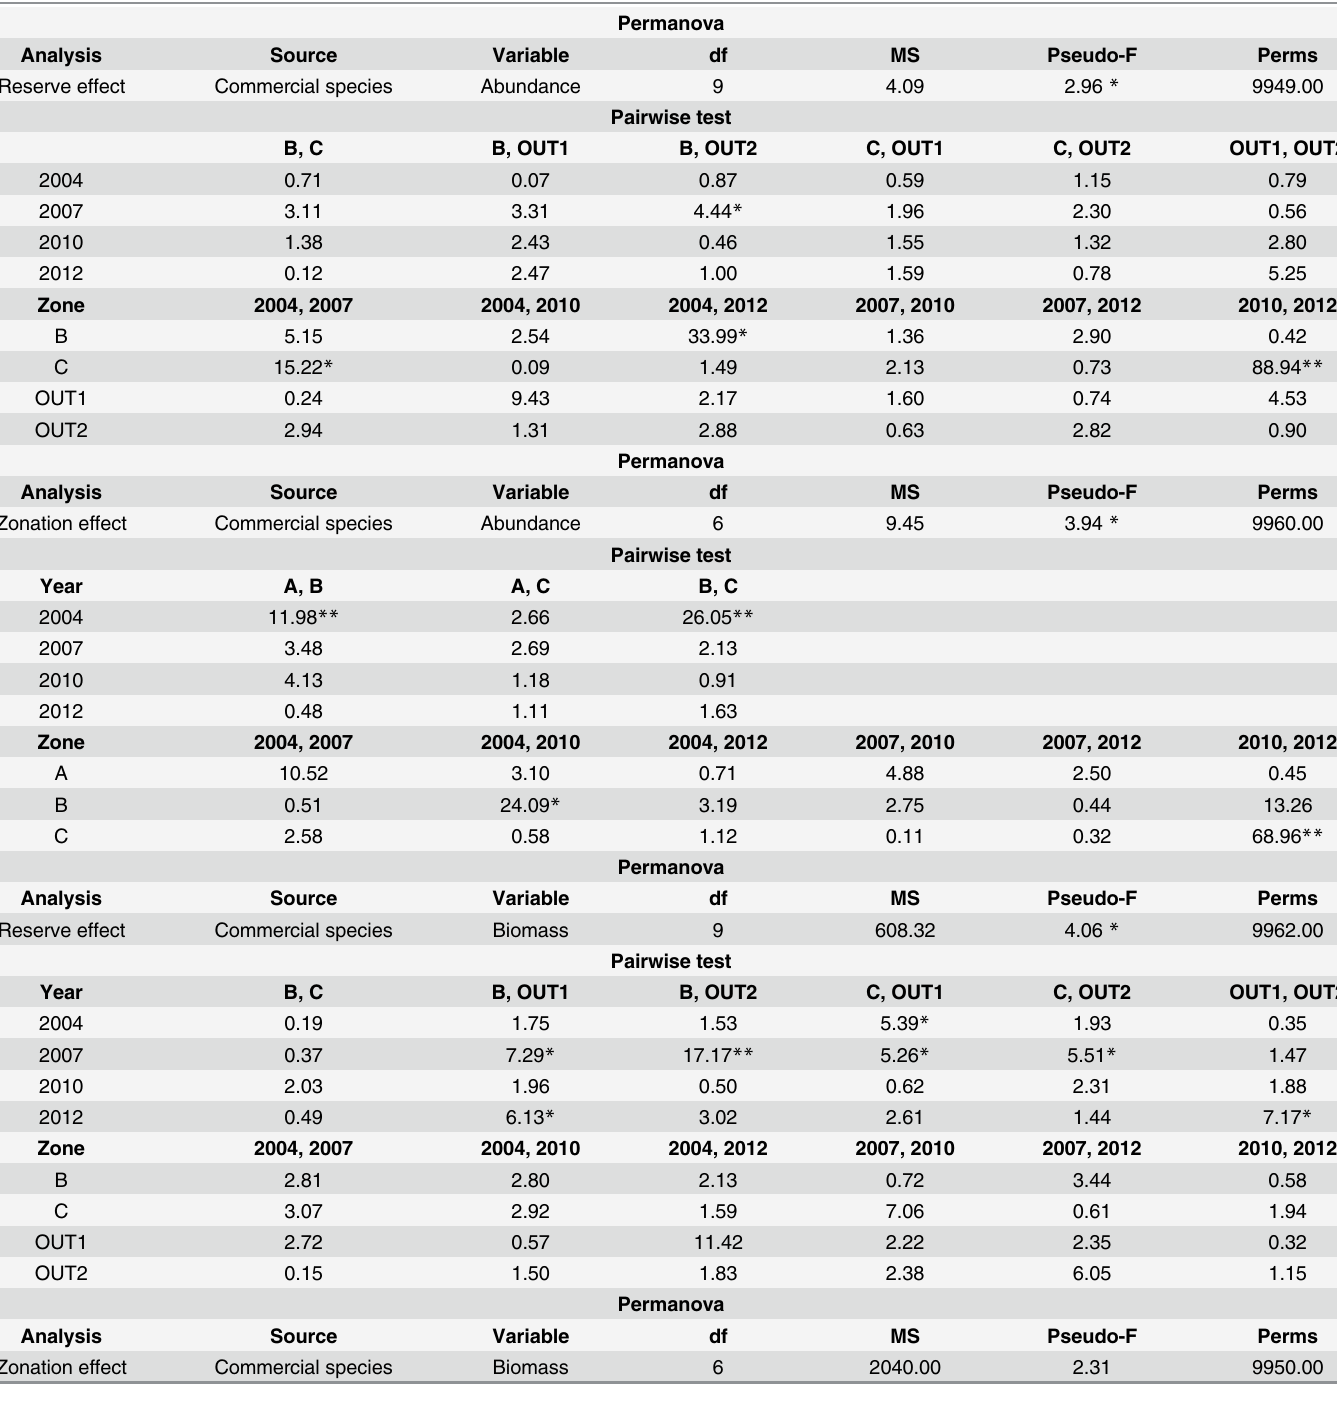
Table 5. Results of univariate Permanova analyses on square root transformed data for “ Year x Protection ” factor for commercial species. Pair- wise tests are reported in the event of statistical